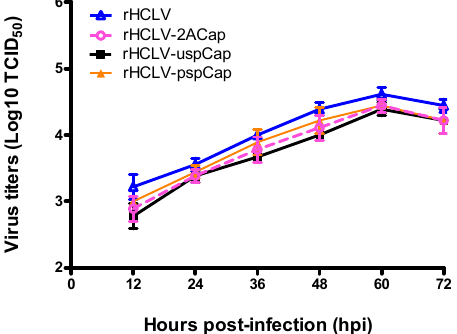
Figure 4. Viral growth properties of the recombinant viruses. SK6 cells were infected with the recombinant viruses or parental virus rHCLV at an MOI of 0.1. The infected cells were harvested by three cycles of freeze-thaw at 12, 24, 36, 48, 60, and 72 h post-inoculation. Viral titers were determined by an indirect immunofluorescence assay and expressed as TCID 50 /mL. The mean value and standard deviation were calculated for three independent experiments.